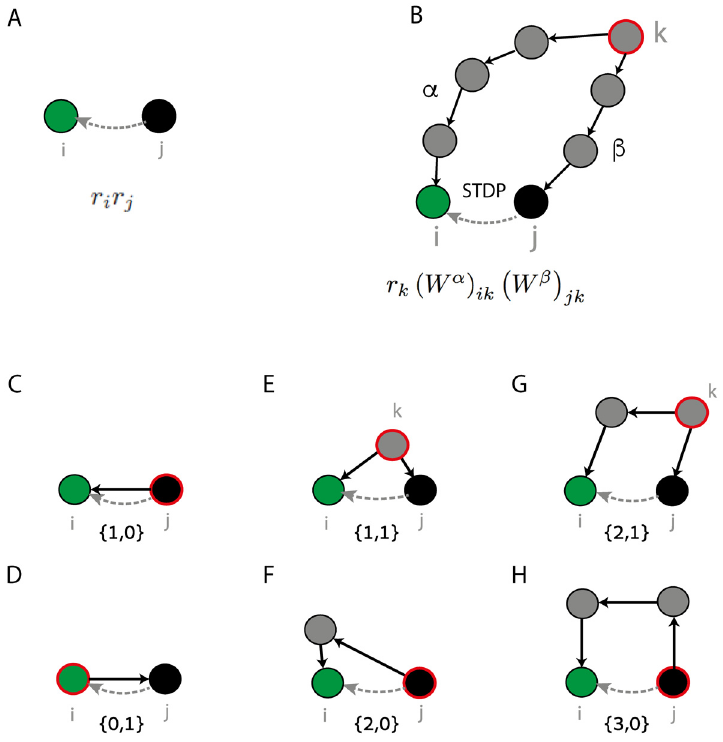
Fig 3. Network motifs that affect the STDP dynamics. A. The first term in Eq 3 is proportional to the average firing rates of the pre and post synaptic neurons. B. General form of a structural motif, contributing to the STDP dynamics in the synapse W ij (dashed line). A source neuron k (red line) projects to the post synaptic neuron i (green) via α synapses, and to the pre synaptic neuron j (black) via β synapses. The contribution is proportional to the firing rate of the source neuron r k and to the product of all synaptic efficacies along the two paths. The expression ( W α ) ik r k ( W β ) jk is a sum over all paths that start from neuron k and reach the post synaptic neuron i via α synapses and the pre synaptic neuron j via β synapses. C-H: Examples of six motifs that affect STDP in the synapse W ij (dashed line), by inducing time dependent coupling between neurons j and i . Black arrows indicate synapses that participate in the motifs. C. One of the first order motifs contains the direct synapse from j to i ( α = 1, β = 0). The source neuron is the pre synaptic neuron j . D. The other first order motif contains the opposite synapse from i to j ( α = 0, β = 1). Here the source neuron is the post synaptic neuron i . E. One of the second order motifs ( α = 1, β = 1). Here the source neuron is some other neuron in the network that projects directly both to i and j . F. Additional example for a second order motif ( α = 2, β = 0). The source neuron is the pre synaptic neuron j , that projects to the post synaptic neuron i through one intermediate neuron. G. Example of a third order motif ( α = 2, β = 1). The source neuron projects directly to the pre synaptic neuron j and via one intermediate neuron to the post synaptic neuron i . H.